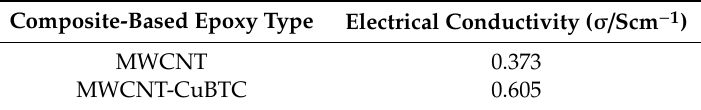
Figure 1. Scanning electron microscopy (SEM) image of ( a ) the multiwall carbon nanotube (MWCNT)-epoxy composite electrode and ( b ) the MWCNT-copper-1,3,5-benzentricarboxylic acid (CuBTC) composite electrode. The inset is an energy dispersive X-ray (EDX) image. Table 1. Electrical conductivity of the composite